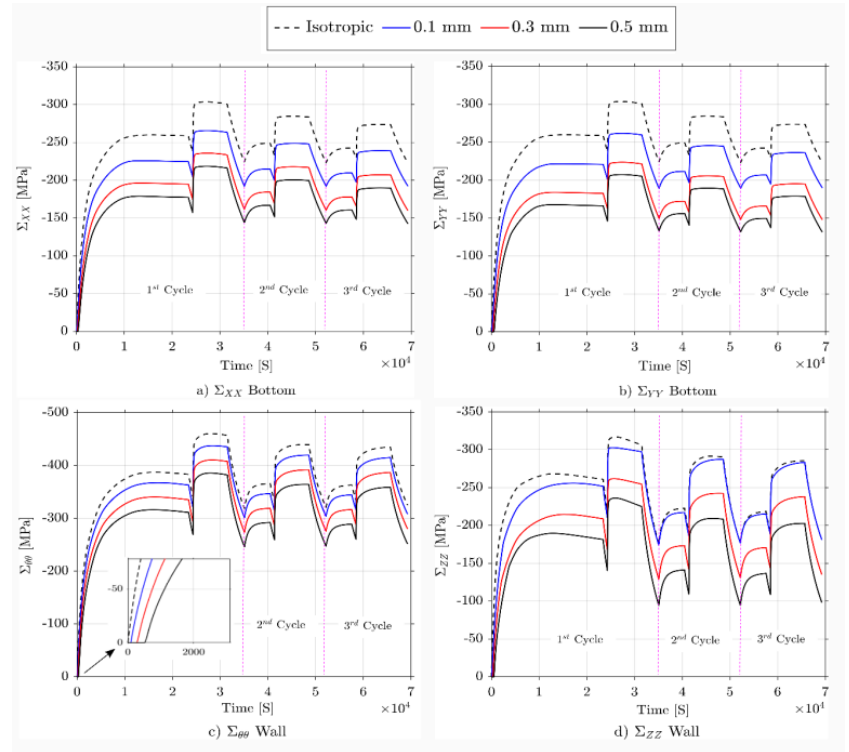
Figure 12. ( a , b ) Time variations of the thermal stresses at the bottom surface and ( c , d ) wall surface of the working lining for different values of bed and head joint thickness during the first three thermal cycles of the steel ladle.